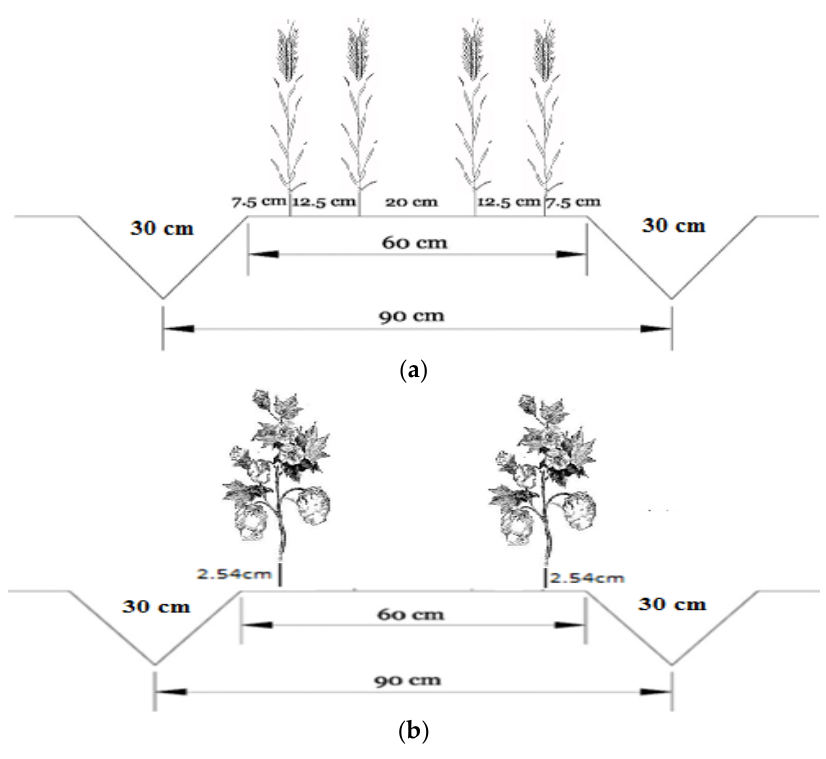
Figure 2. ( a ) Geometry of wheat lines on bed. ( b ) Geometry of cotton and maize on bed.